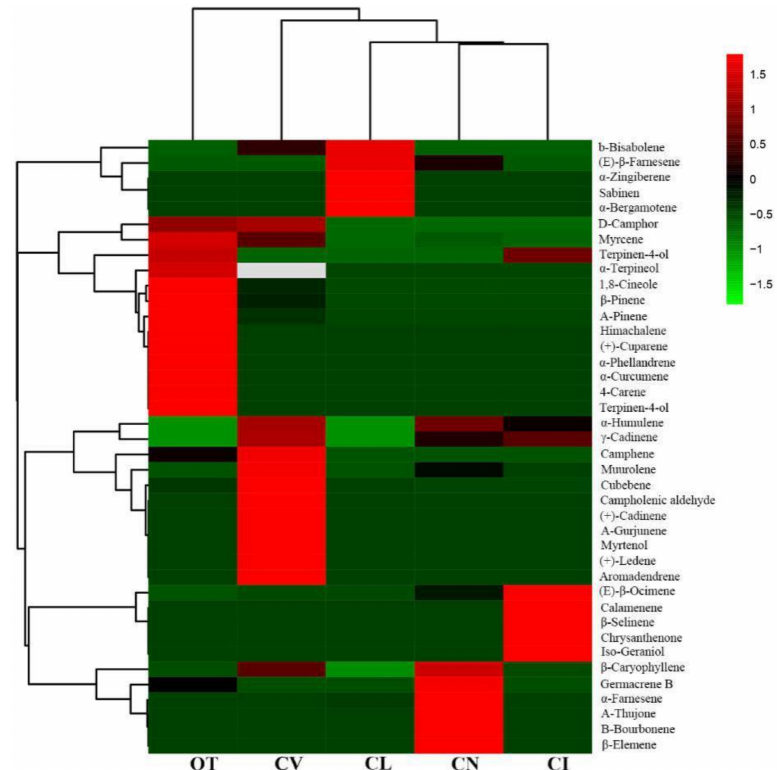
Figure 3. Clustering of terpenoids and the five wild species. The color scale of the heat map ranges from green (value, − 1.5) to light red (value, 1.5). The emission values were normalized by log 10